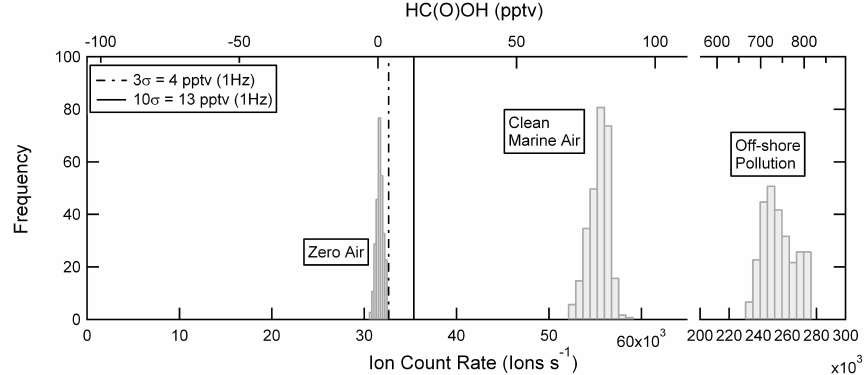
Fig. 5. Frequency distributions of ion count rate at − 45Th of 1Hz data taken from 5min sampling periods while sampling zero air, clean marine air, and polluted air aboard the R/V Atlantis .